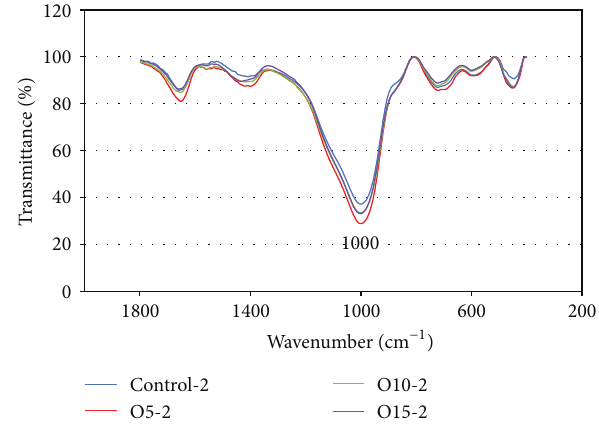
Figure 13: FT-IR spectra of the geopolymer